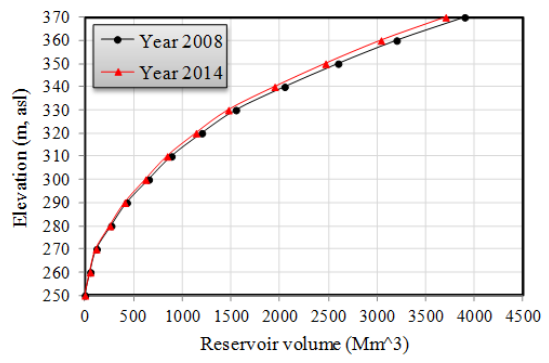
Figure 8. Capacity of Dez dam’s reservoir at various levels